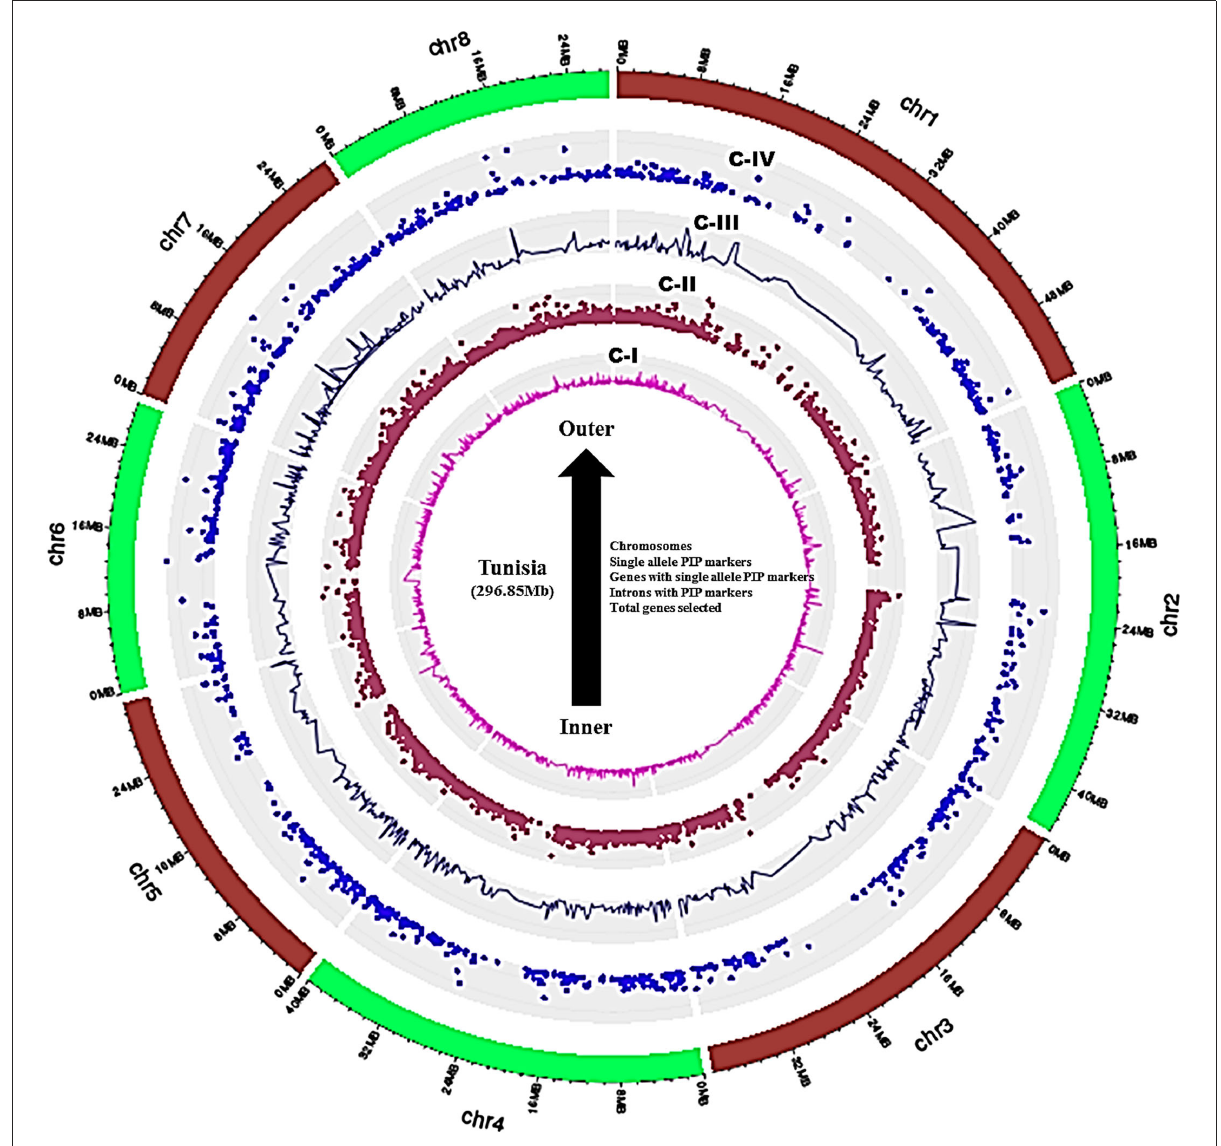
FIGURE2 Circos graph depicting the physical positions of genes, intron numbers, and lengths targeted.